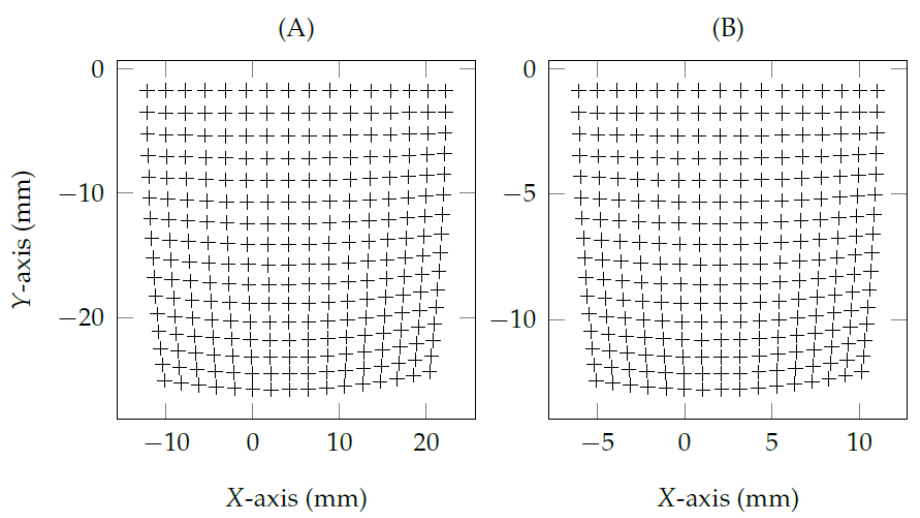
Figure 3. The eye-camera aligned with the eyes’s optical axis and moving in depth. The crosses represent a set of 16 × 16 simulated pupil centers from a remote eye tracker. In these simulations, the eye-camera location (in millimeters) related to the world coordinate system (i.e., the bottom-center of the screen) were: ( A ) ( 0,350,0 ) ; and ( B ) ( 0,350, − 550 )